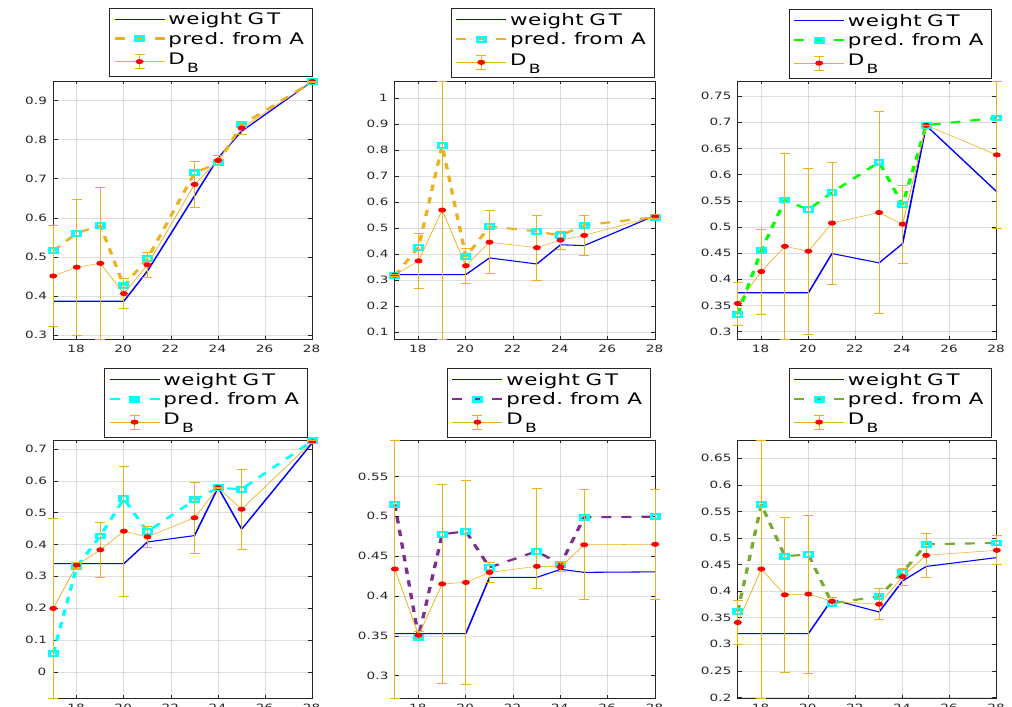
Figure 12. Leaf weight trends both computed from the predicted leaf area and as given by the manual measurements. As for plants height the error is computed basing on the Bhattacharyya distance between probability functions (see Equation (8)), for the same reasons, namely we have comparable probabilities, although not comparable samples. In fact, data from vision are given for DAS 18–28, while the area computed by the network, using the weights the leaf area, are limited to DAS 21, 24, 25 and 28, for Racks 7–12. We recall that Racks 7–9 ( top ) are low density plant distribution, while Racks 10–12 ( bottom ) are high density plants